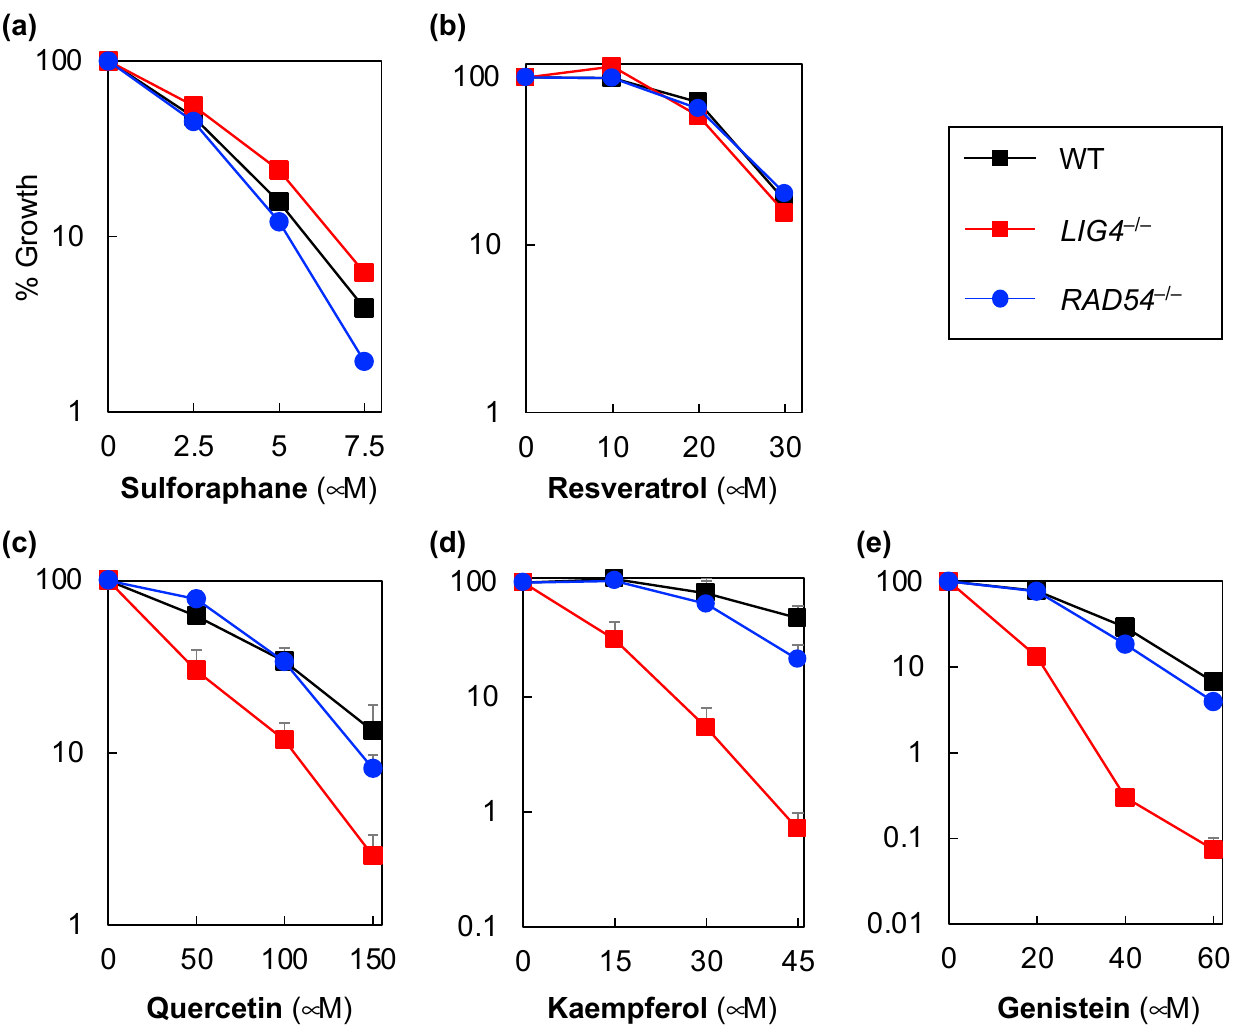
Figure 2. Sensitivity of human LIG4 − / − (non-homologous end-joining-deficient cells), RAD54 − / − (homologous recombination-deficient cells), and wild-type Nalm-6 cells to natural antioxidants. Sensi- tivities of human, LIG4 − / − , RAD54 − / − , and wild-type Nalm-6 cells to sulforaphane ( a ), resveratrol ( b ), quercetin ( c ), kaempferol ( d ), and genistein ( e ) determined using a growth inhibition assay. The cells were treated with the drug for either 96 h ( a , c – e ) or 192 h ( b ). Data are presented as the mean ± standard deviation of three independent experiments. Where absent, error bars fall within the symbols.